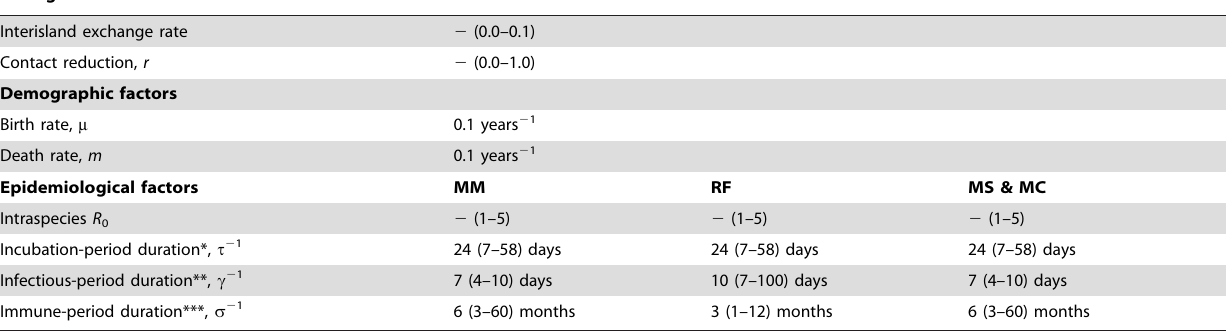
Ecological factors Interisland exchange